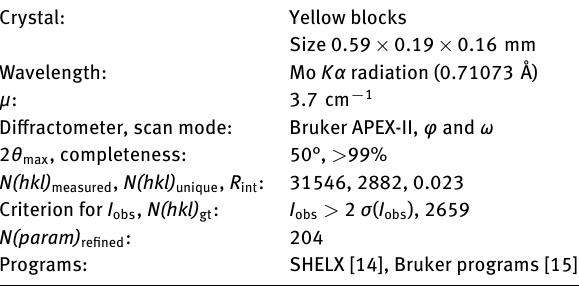
Table 2: Fractional atomic coordinates and isotropic or equivalent isotropic displacement parameters (Å 2